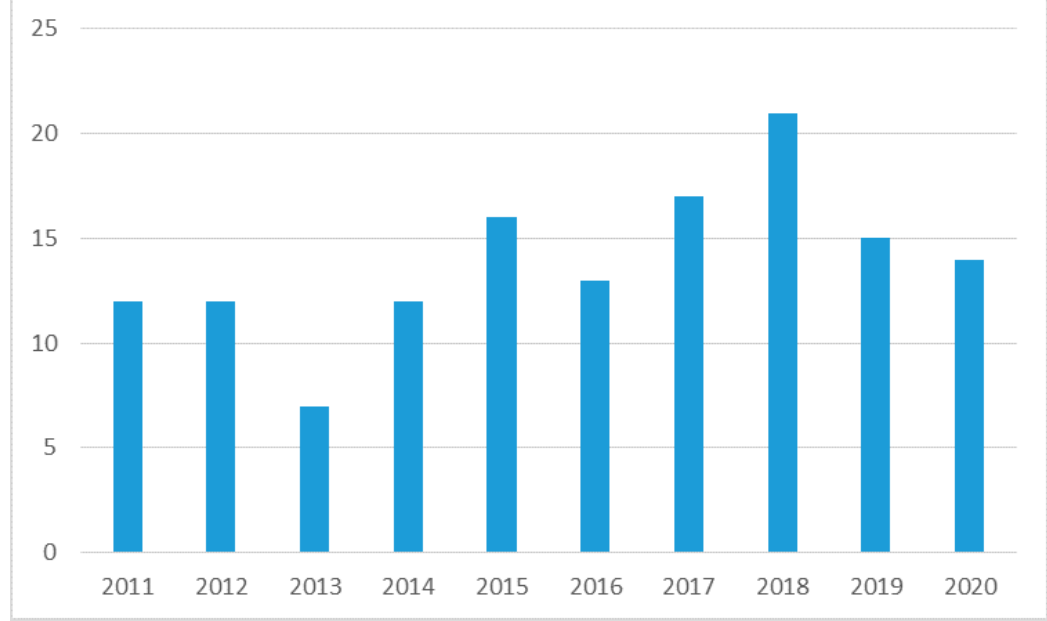
Figure 3. Number of papers published in the last 10 years. Source: Generated by the Web of Science analysis report.